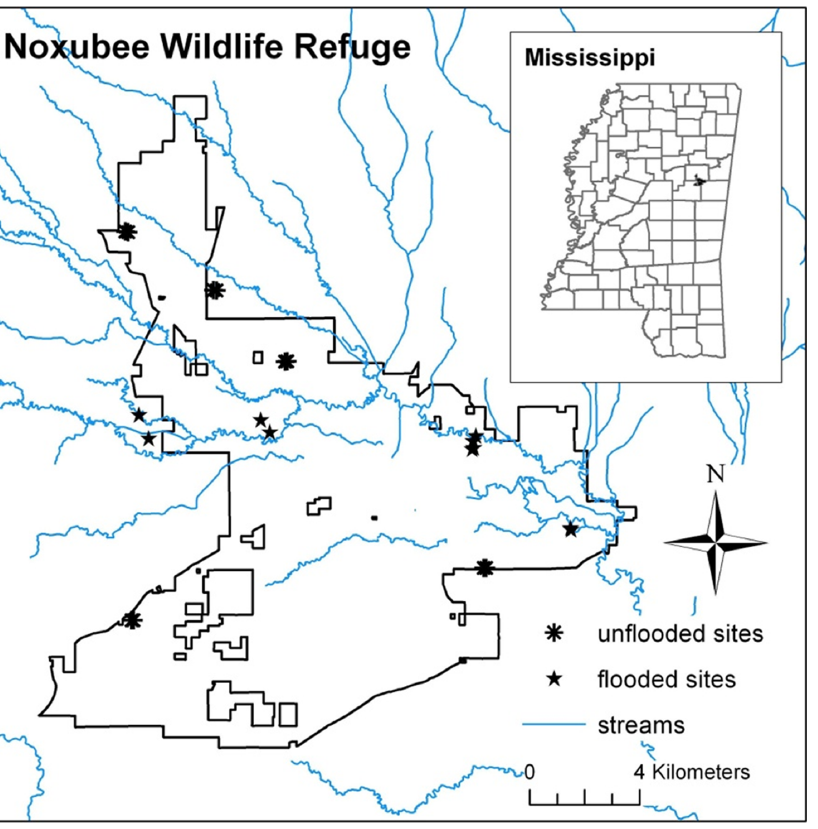
Figure 1. Map of study locations in northeastern Mississippi (Note: some locations are too close together to appear individually in this figure).